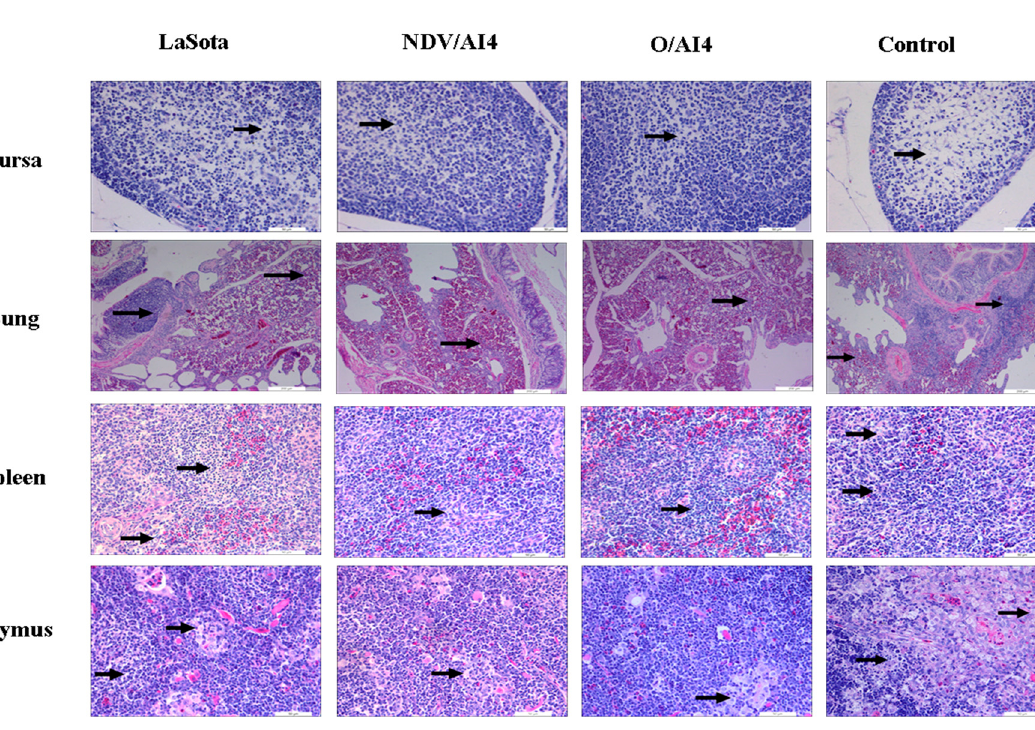
Figure 3. Photomicrographs illustrating hematoxylin and eosin (HE) staining on sections of the bursa of the Fabricius, lung, spleen and thymus at 3 dpc. Magnification for panels lung, n = 100×, bars = 200 μ m; all other panels, 400×, bar = 50 μ m. First row: bursa tissue samples from LaSota, NDV/AI4, O/AI4 vaccinated groups showed moderate edema (black arrows), while tissue from the control group showed severe edema. Second to fourth row: spleen, thymus and lung tissue samples from LaSota vaccinated group showed mild lymphocytosis (black arrows) which was more severe than that from the NDV/AI4, O/AI4 vaccinated groups. Moderate lymphocytosis along with lymphoid necrosis was observed in the tissues from the control group.